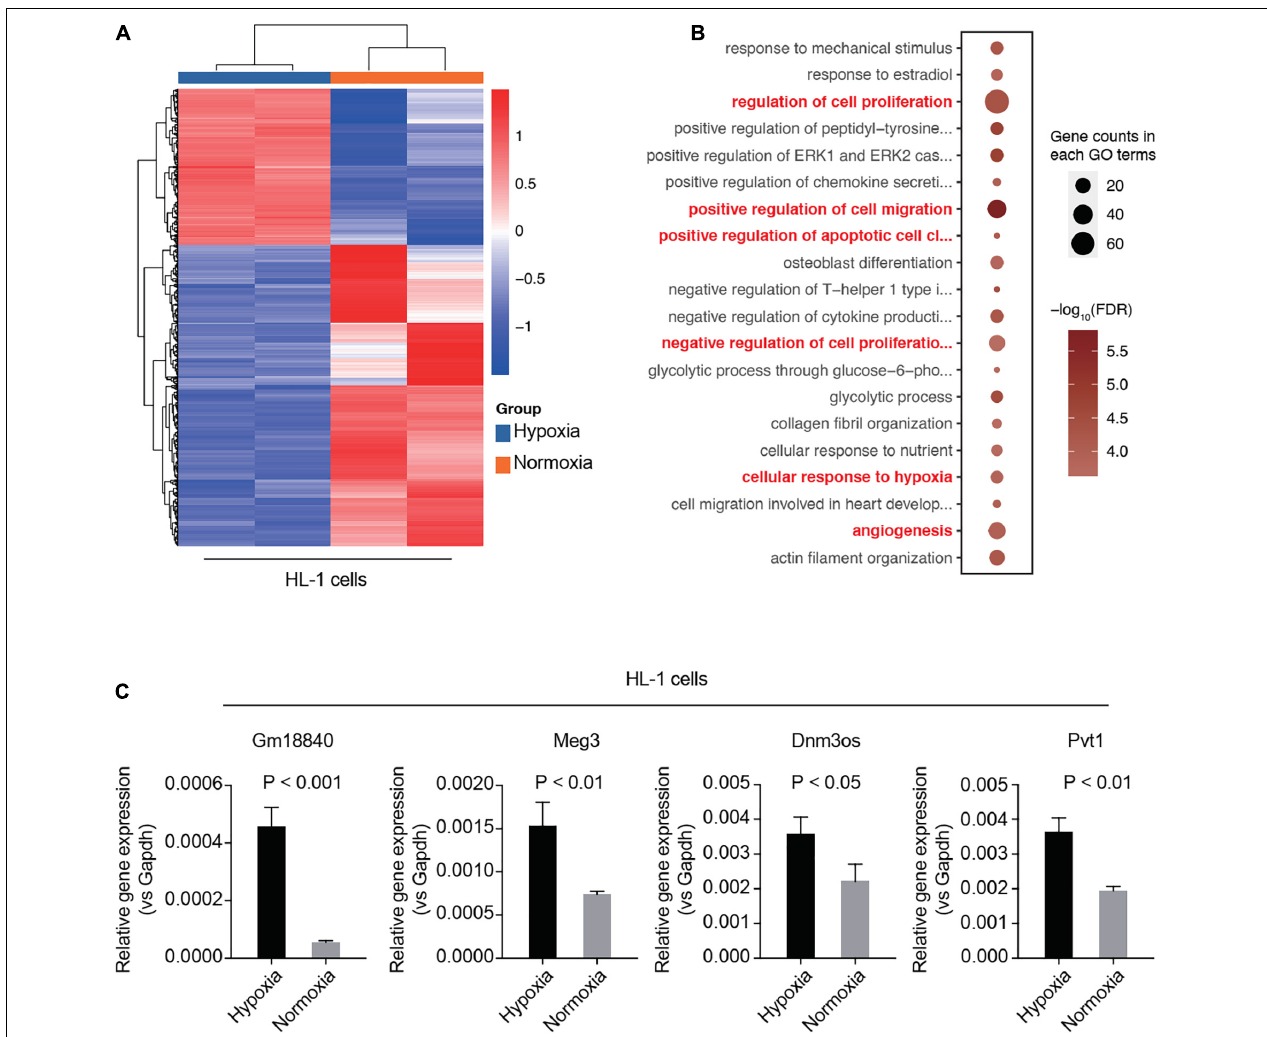
FIGURE 2 | Validation of identified lncRNAs using a simulated ischemia/reperfusion model in HL-1 cells. (A,B) RNA-seq analysis in an in vitro model of simulated ischemia. HL-1 cells were cultured under normoxia or hypoxia. Differentially expressed genes between normoxia and hypoxia in HL-1 cells are shown (A) . Gene ontology analysis was performed using the differentially expressed genes (B) . (C) Validation of the differentially expressed lncRNAs by qRT-PCR in the murine cardiac muscle cell line HL-1 upon hypoxia treatment. HL-1 cells were cultured with 20% oxygen (normoxia) or 1% oxygen (hypoxia) for 24 h. The expression of these genes was normalized to